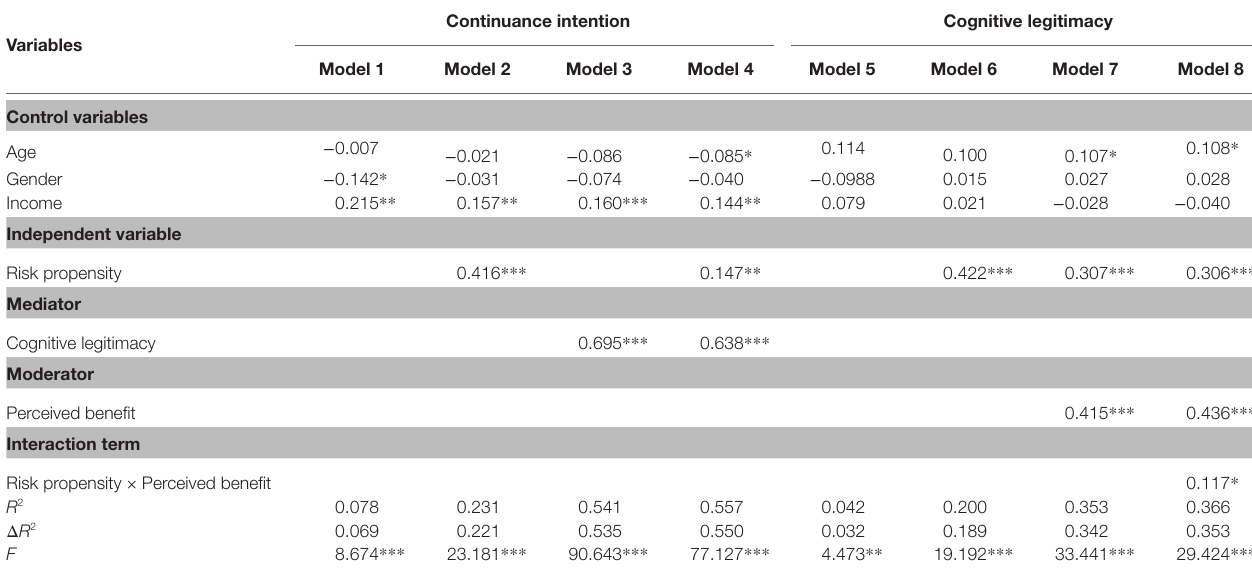
TABLE 3 | Results of mixed model analysis for the hypothesized relationships.